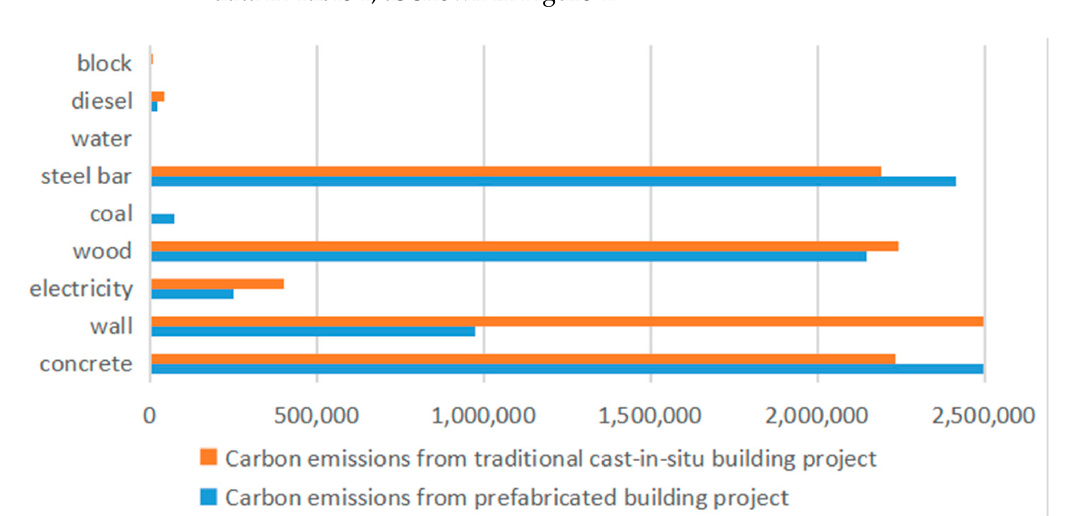
Table 1. Differences in carbon emissions during the field installation stage of the project.